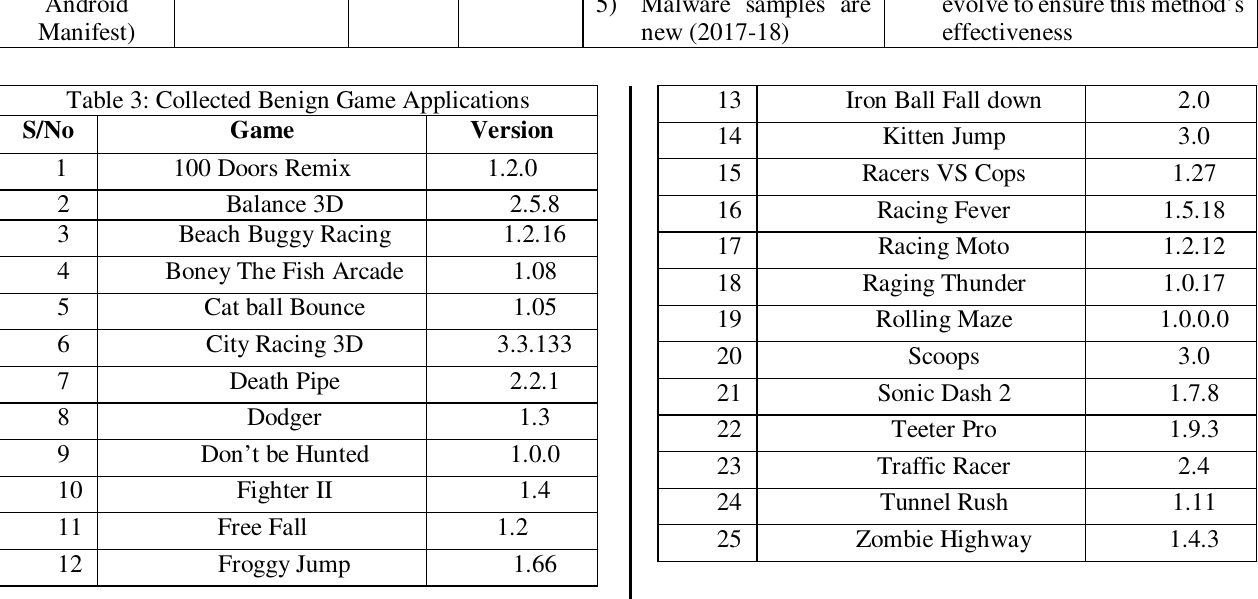
Table 3: Collected Benign Game Applications